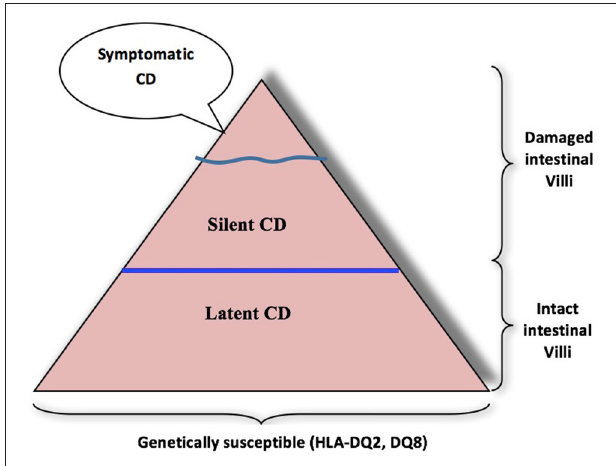
FIGURE 1 | Iceberg for gluten-sensitive